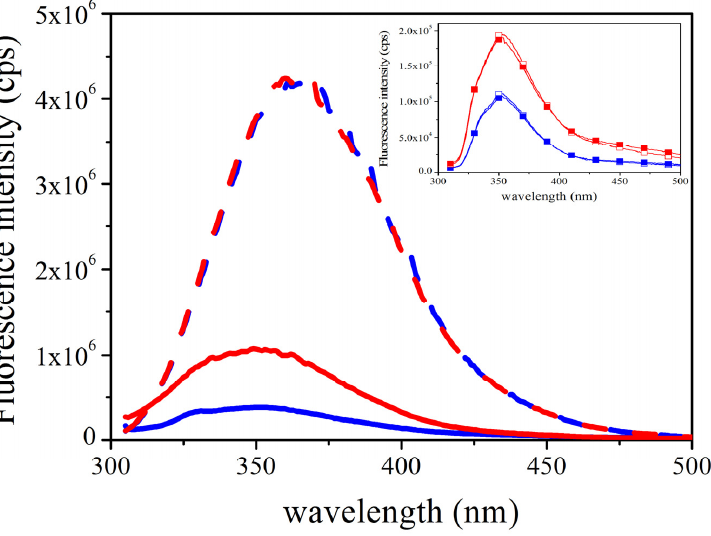
Figure 4. The tryptophan fluorescence intensity of Tm -MreB depends on the buffer conditions. The fluorescence intensity of the tryptophan residue was measured in salt-free (blue line) and high-salt (red line) environments. The fluorescence intensity of the tryptophan residue itself is not affected by buffer conditions (dashed lines). The tryptophan residue of Tm -MreB shows a lower fluorescence intensity than tryptophan alone at the same concentration, showing the shadowing effect of the surrounding residues in Tm -MreB. This effect is more pronounced in salt-free buffer (blue curve), probably due to conformational changes. Inset: The presence or binding of ATP has no effect on the fluorescence of tryptophan. In an independent measurement, the fluorescence intensity of Tm -MreB was measured in a salt-free environment (blue curves) and in the presence of salt (red curves) in the presence (filled symbols) and absence (empty symbols) of